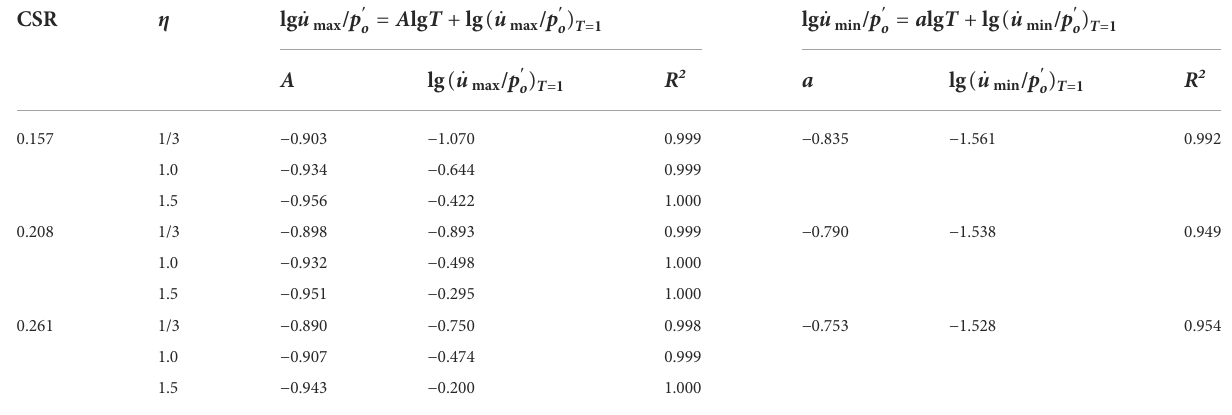
lg ( _ u max / p ′ o ) T (cid:1) 1 : normalized maximum excess pore water pressure rate at a unit time; lg ( _ u min / p ′ o ) T (cid:1) 1 : normalized minimum excess pore water pressure rate at a unit time; A , is expressed as the decay rate of normalized maximum excess pore water pressure rate with time in logarithmic coordinates; a is expressed as the decay rate of normalized minimum excess pore water pressure rate with time in logarithmic coordinates; η is the slope of stress